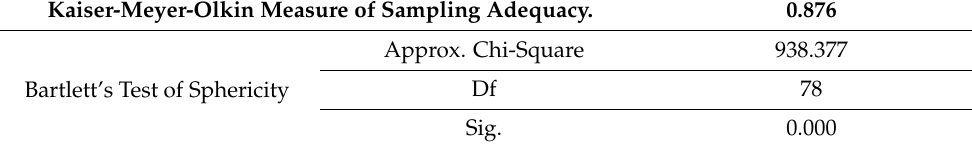
Table 2. KMO and Bartlett’s